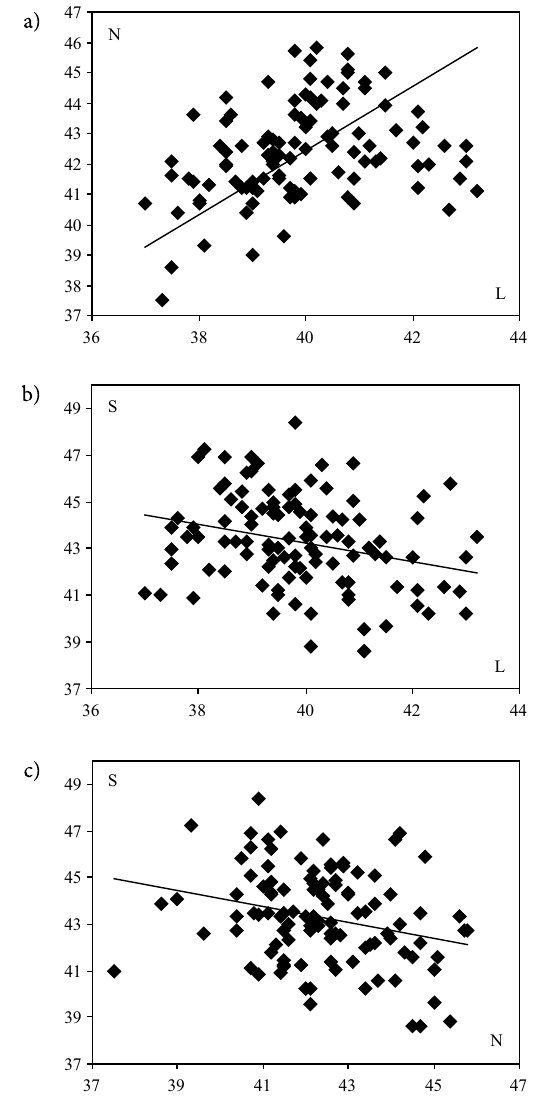
Fig. 6. a – correlation between rebound indices recorded by L-type and N-type original Schmidt rebound hammers for the individual testing locations; b – correlation between rebound indices recorded by L-type original Schmidt and N-type Silver Schmidt rebound hammers for the individual testing locations; c – correlation between rebound indices recorded by N-type original Schmidt and N-type Silver Schmidt rebound hammers for the individual testing